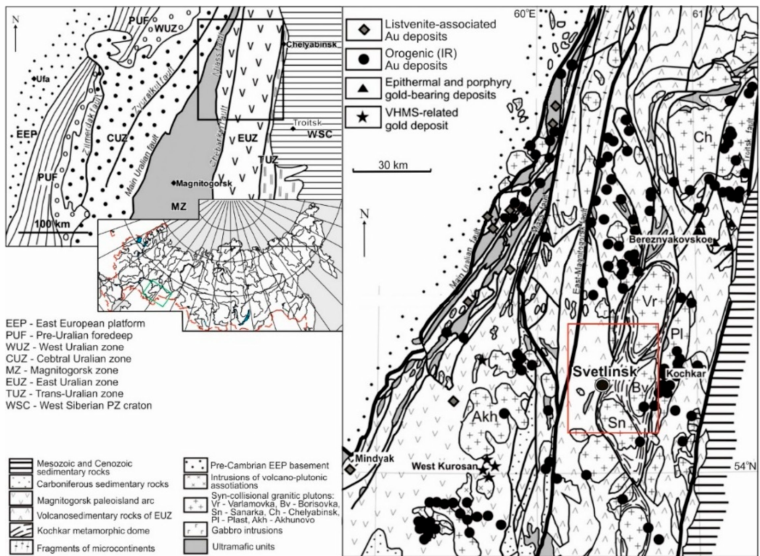
Figure 1. Geological setting of gold deposits in the South Urals, modified after [32]. The red square corresponds to Figure 2.